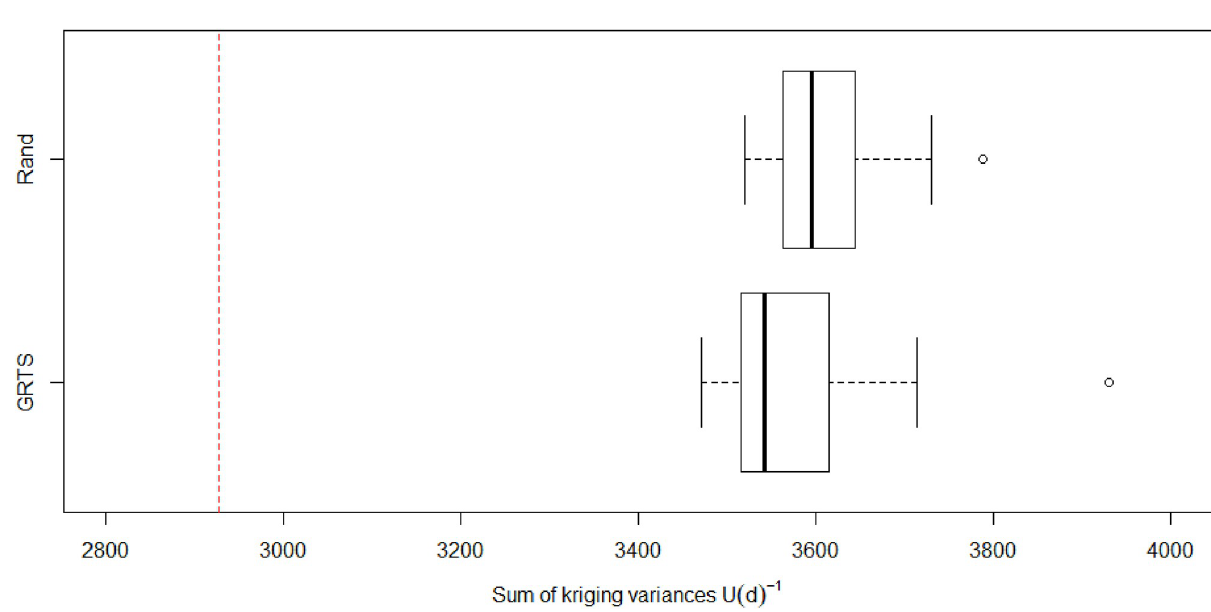
Fig 7. The sum of kriging variances for both Generalised Random Tessellation Sampling (GRTS) and random designs computed using 1000 draws from the priors set on the covariance parameters. The dashed red line represents the sum of the kriging variances for the adaptive design. The performance of the adaptive design is plotted this way as opposed to as a boxplot because there is only one adaptive design.